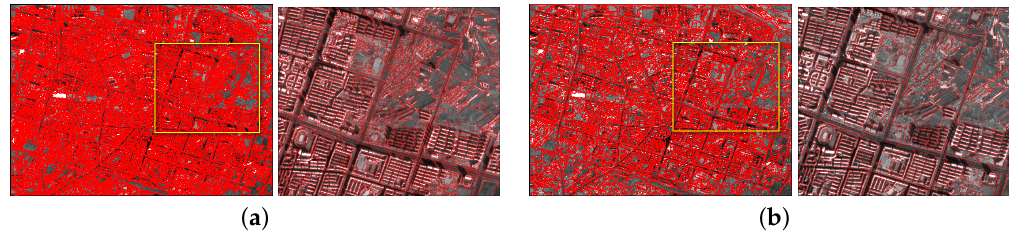
Figure 8. The results of image segmentation and region merging process: ( a ) the initial segmentation; ( b ) the segmentation after the merging process, the false segment is removed, and the segmentation quality is obviously